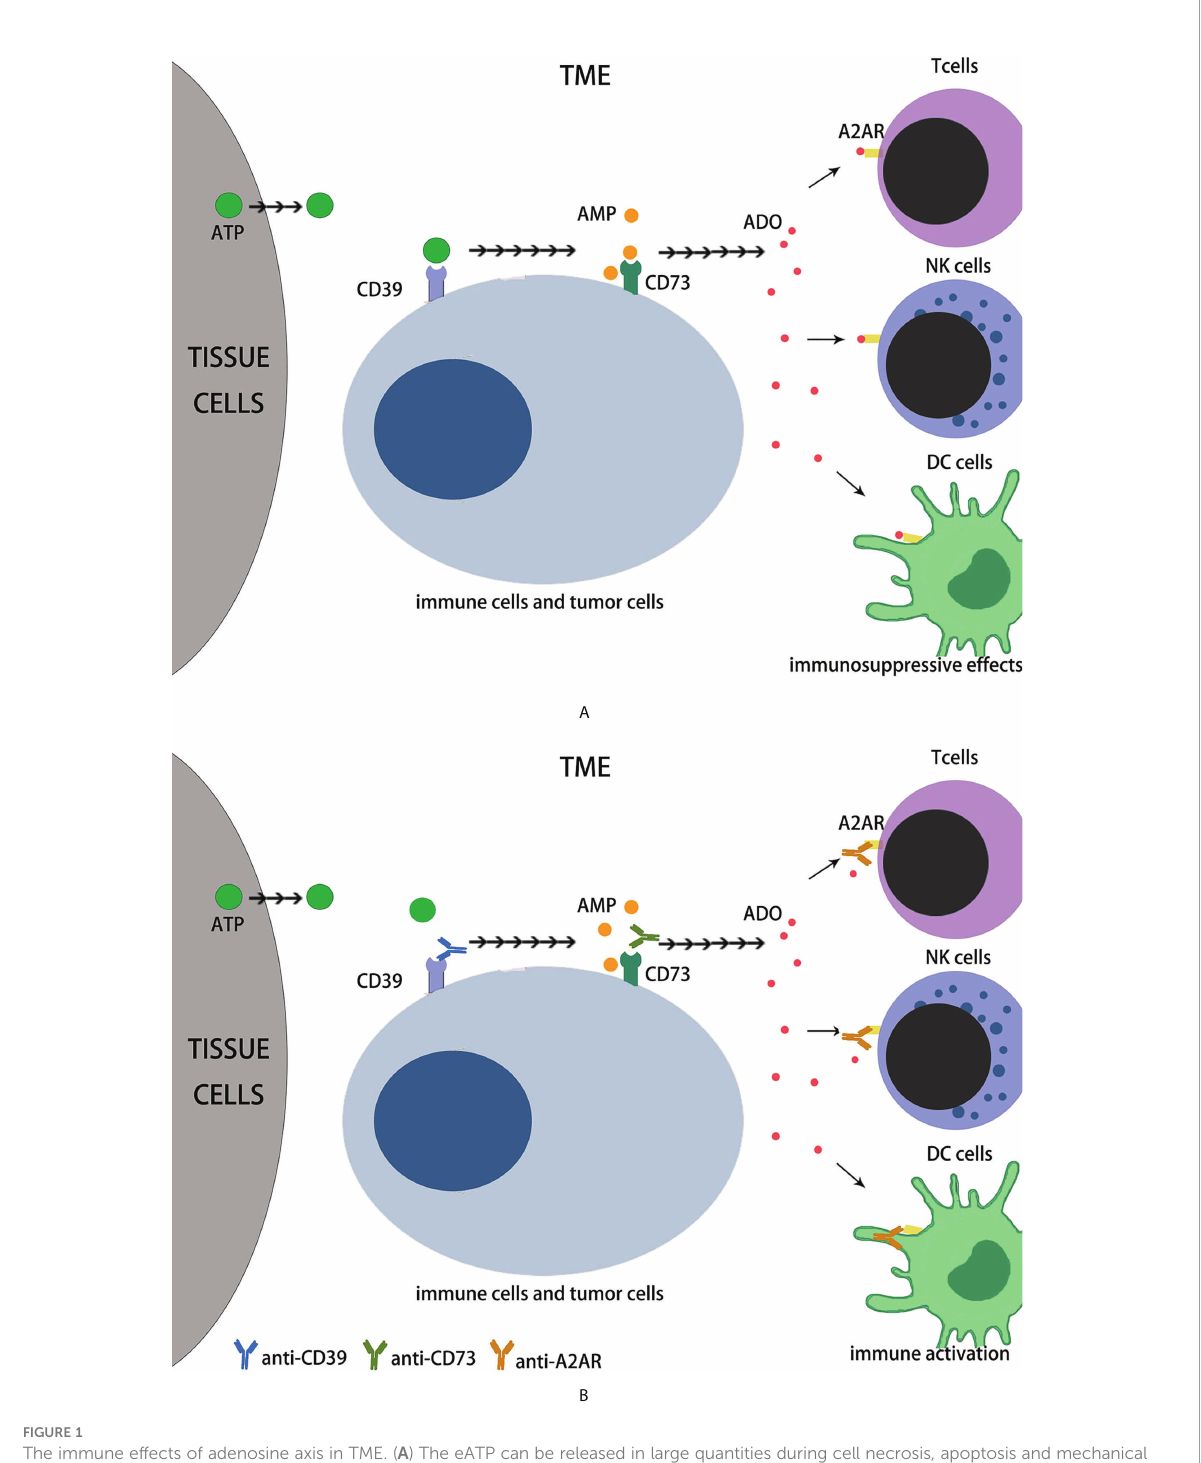
FIGURE 1 The immune effects of adenosine axis in TME. ( A ) The eATP can be released in large quantities during cell necrosis, apoptosis and mechanical damage, and can be actively secreted by tumor cells and other cells in the TME, which is triggered by hypoxia, chronic in fl ammation, nutrient deprivation, or cytotoxic drugs. Extracellular ATP is broken down by CD39 to AMP, then CD73 to adenosine. Extracellular adenosine binds to A2AR on immunocytes such as T cells, NK cells and DC cells, inhibiting their immune function. ( B ) Role of monoclonal antibodies in adenosine axis. CD39 mAb prevents eATP from binding to CD39 to reduce AMP production; CD73 mAb prevents AMP from binding to CD73 to reduce ADO production. A2AR mAb prevents ADO from binding to A2AR and inhibits its immunosuppressive